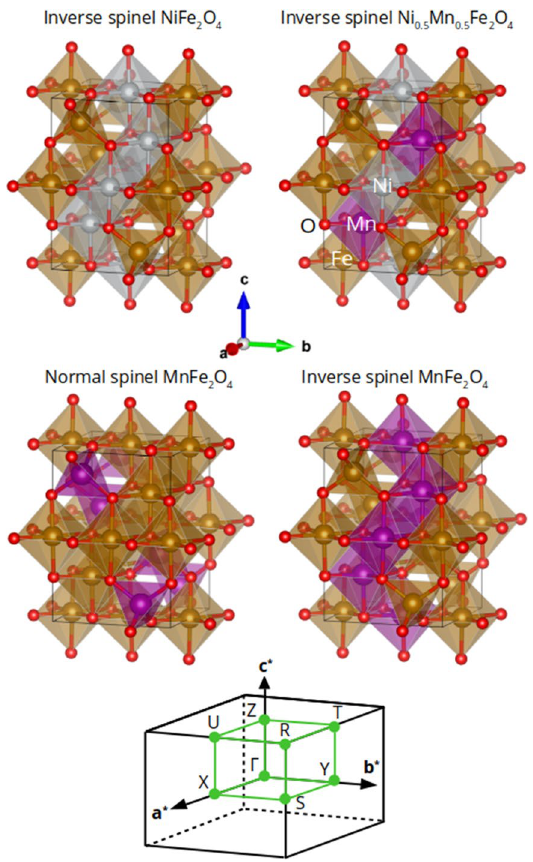
Figure 16. The considered unit cells of inverse NiFe 2 O 4 , inverse Ni 0.5 Mn 0.5 Fe 2 O 4 , and both normal and inverse MnFe